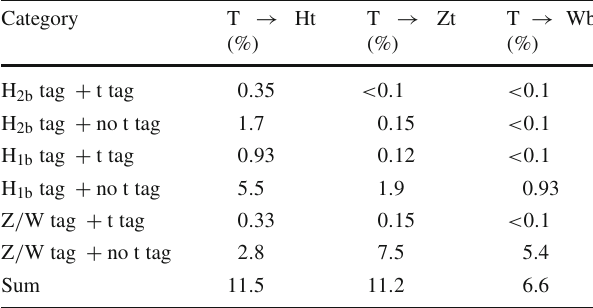
Table 1 Signal selection efficiency for the three T decay modes in each category for a signal with M Z (cid:3) = 2 . 5TeV and M T = 1 . 3TeV, taking into account branching fractions B ( tHt → (cid:8) +jets ) = 0 . 294, B ( tZt → (cid:8) +jets ) = 0 . 317, and B ( tWb → (cid:8) +jets ) = 0 . 255 [64], where (cid:8) +jets is a final state with exactly one electron or muon originating from the decay of one of the top quarks, including electrons and muons from tau lepton decays. The last row of the table shows the total selection efficiency summed over all six categories. The efficiencies are shown after all selection requirements, including those on the reconstructed tt system as detailed in Sect.